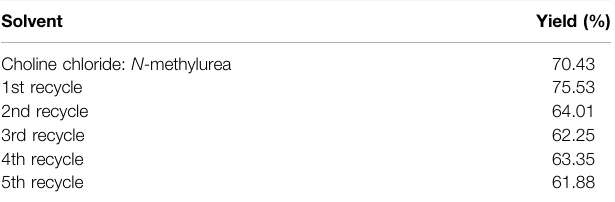
TABLE 3 | The impact of solvent recycling on product yield for model reaction. Solvent Yield (%) Choline chloride: N